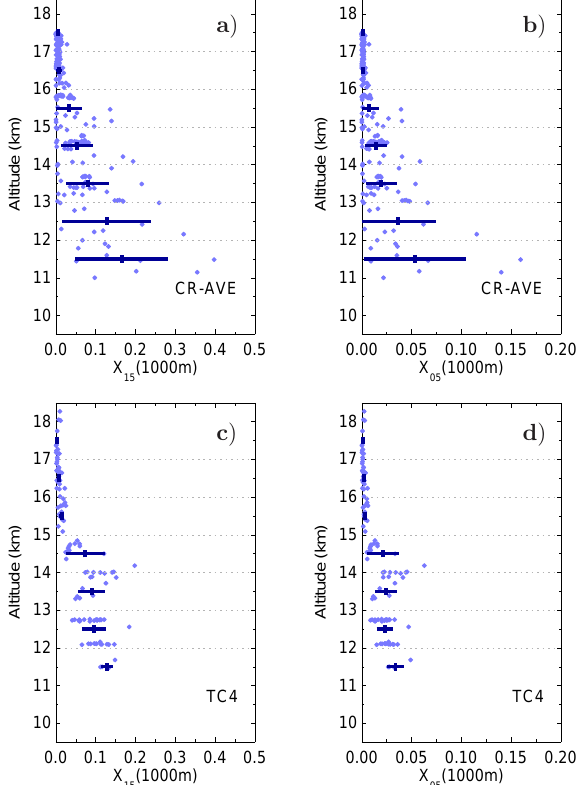
Fig. 10. The correlation between observed CHBr 3 and modelled T15 during CR-AVE (plot a, data from figure 8b and figure 9a) and TC4 (plot b, data from figure 8e and figure 9c). The dots are coloured by altitude—see the legend at the bottom of plot b. The grey lines indicate where there is a linear relationship between observation and model, and the scaling factor required to match model to observation is noted at the left end of each line. Note that CHBr 3 was not detected in 47 (2) out of 230 (112) samples collected during CR-AVE (TC4); these data are not presented in plot a (b), though they are included in the correlation coefficient calculations.